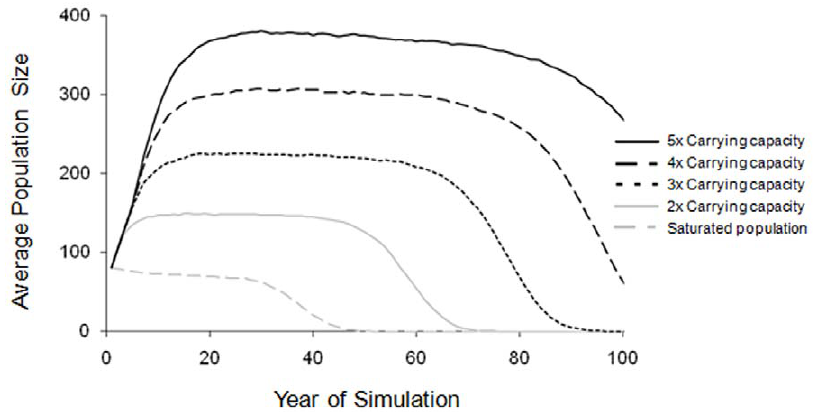
Figure 4. Carrying capacity determines persistence. Average projected size of simulated wild dog populations over 100 years with the carrying capacity parameter set at varying levels in relation to initial population size. Model assumes an inbreeding avoidance threshold of F=0.20.